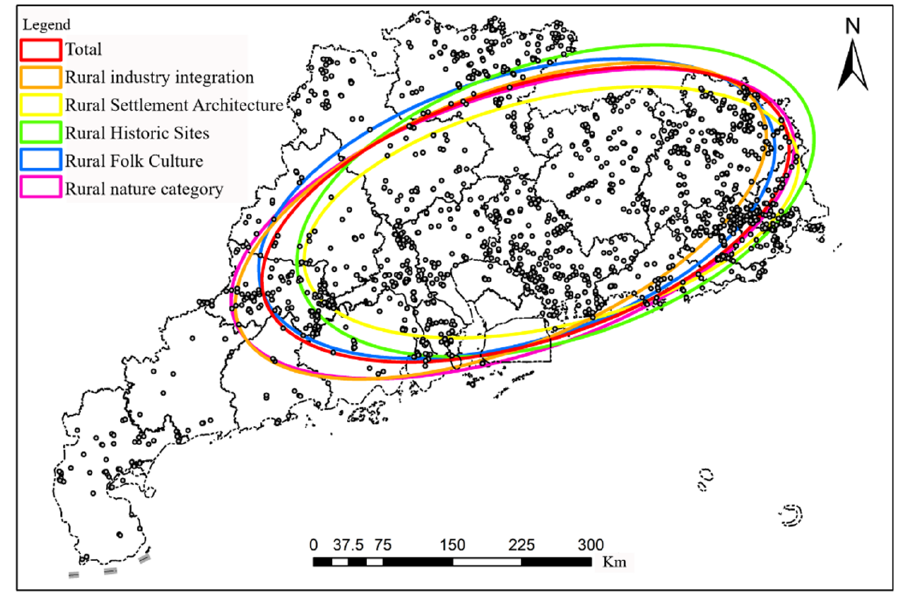
Figure 5. Ellipse analysis of the standard deviation of rural tourism resources in Guangdong.